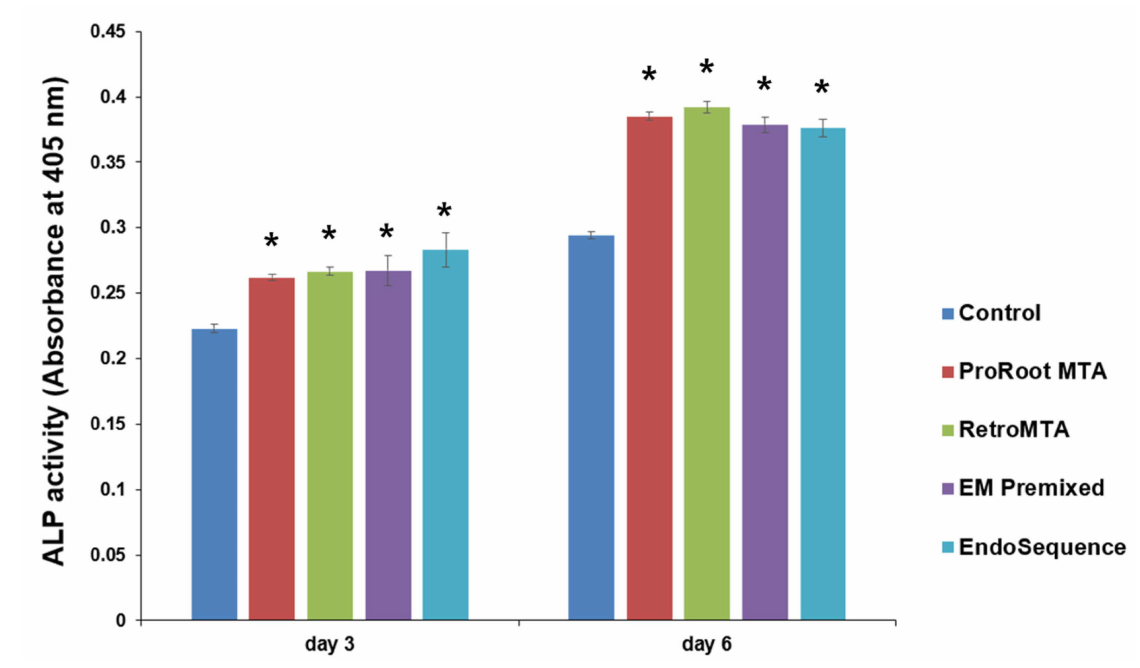
Figure 5. Comparison of alkaline phosphatase (ALP) activity by experimental cement. * p < 0.05 compared to the control group at each time point. Error bars mean standard deviations.